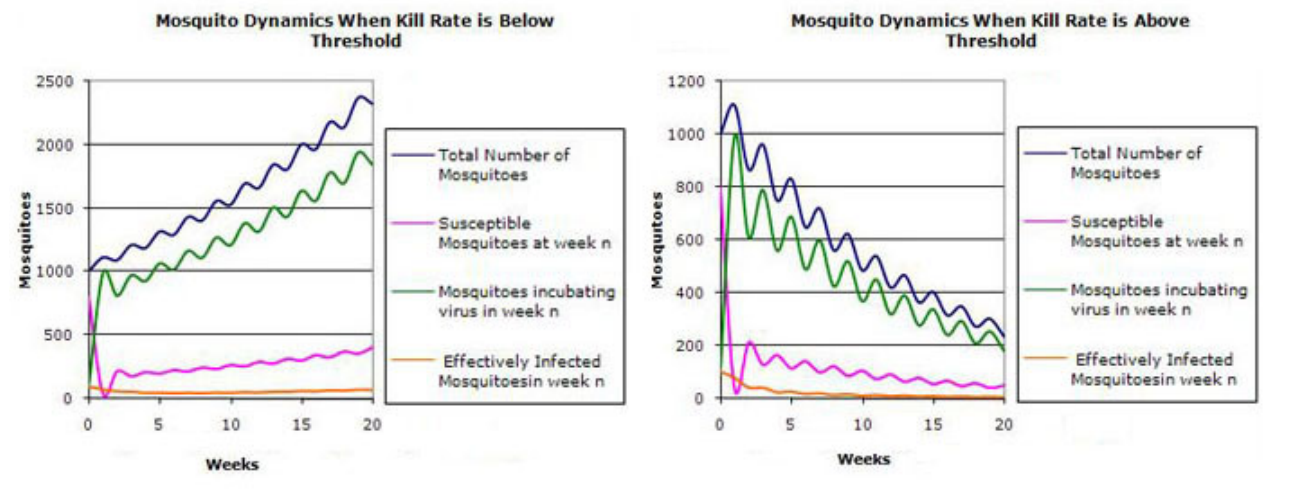
Fig. 2. The discrete time analysis by Thomas and Urena (2001) indicated that the important variable to track in the control of West Nile virus is the total number of mosquitoes as a function of time t in weeks, TM(t). The left inset shows that pesticide spraying to control mosquito populations is ineffective when the spray kill rate is below a threshold value. The right inset describes the effectiveness of spraying when the spray kill rate is higher than the threshold